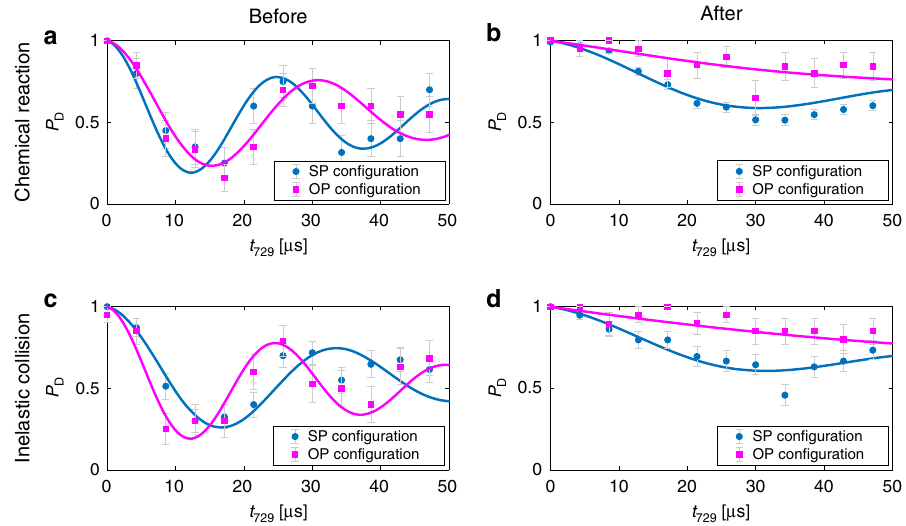
Fig. 5 Tracing molecular states during inelastic processes. State dynamics of two molecules (experiment nos. 1 and 2 in Fig. 4) probed by the present SP/OP protocol under a chemical reaction (a → b) and a quantum jump (c → d). (a → b): An N þ background-gas H 2 molecule and converts into N 2 H + . (c → d) An N þ collision or photon scattering. Error bars represent 1 σ binomial uncertainties.